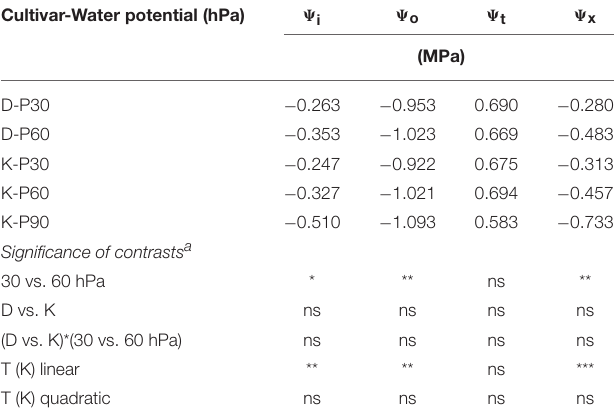
TABLE 5 | Effect of cultivar (Diana—D and Kabiria—K) and growing-media matric potential (P) on total water consumption and water-use efficiency (WUE) of subirrigated soilless tomato under controlled water stress